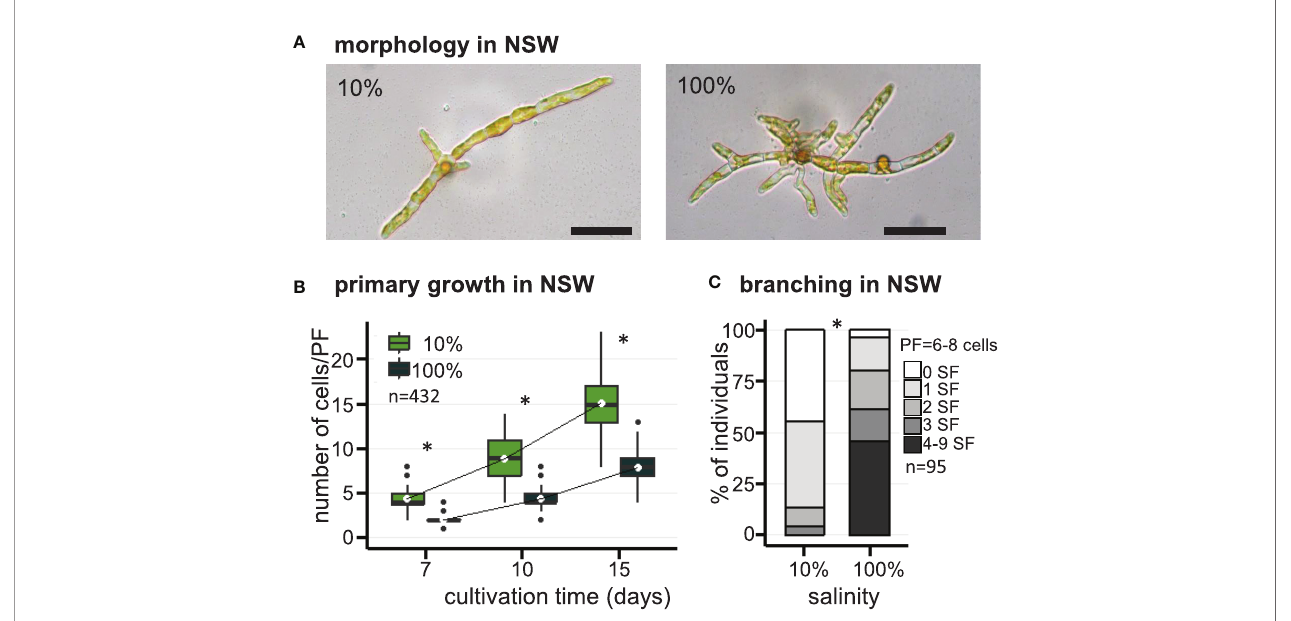
FIGURE 1 | Morphology of E. subulatus grown in natural seawater (NSW) featuring distinct salinities. (A) Morphology of E. subulatus parthenosporphytes cultivated for 15 days in NSW featuring distinct salinities. Scale bar = 50 µm. (B) Elongation of E. subulatus primary fi lament (PF) was signi fi cantly greater (Mann-Whitney test: p < 0.001) when the gametes were cultivated in diluted seawater (10%) rather than in undiluted seawater (100%). (C) The branching activity of E. subulatus was signi fi cantly greater (Mann-Whitney test: p < 0.001) when the gametes were cultivated in undiluted seawater (100%) rather than in diluted seawater (10%). * above bars indicates signi fi cant differences.